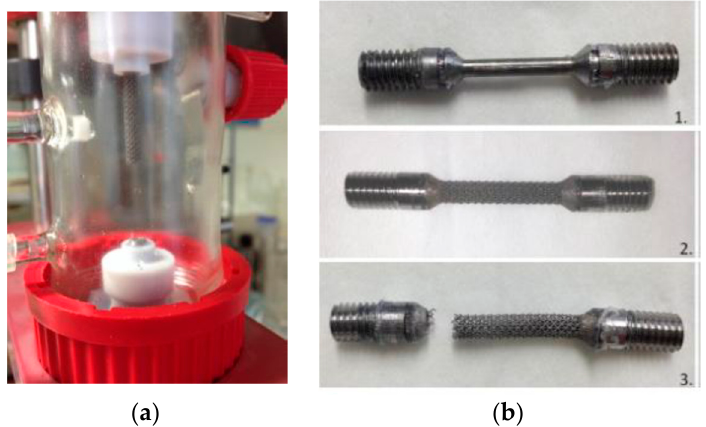
Figure 25. ( a ) Failure of the Ti6Al4V alloy scaffold specimen before fatigue corrosion tests; ( b ) Ti-based alloys samples before and after test.